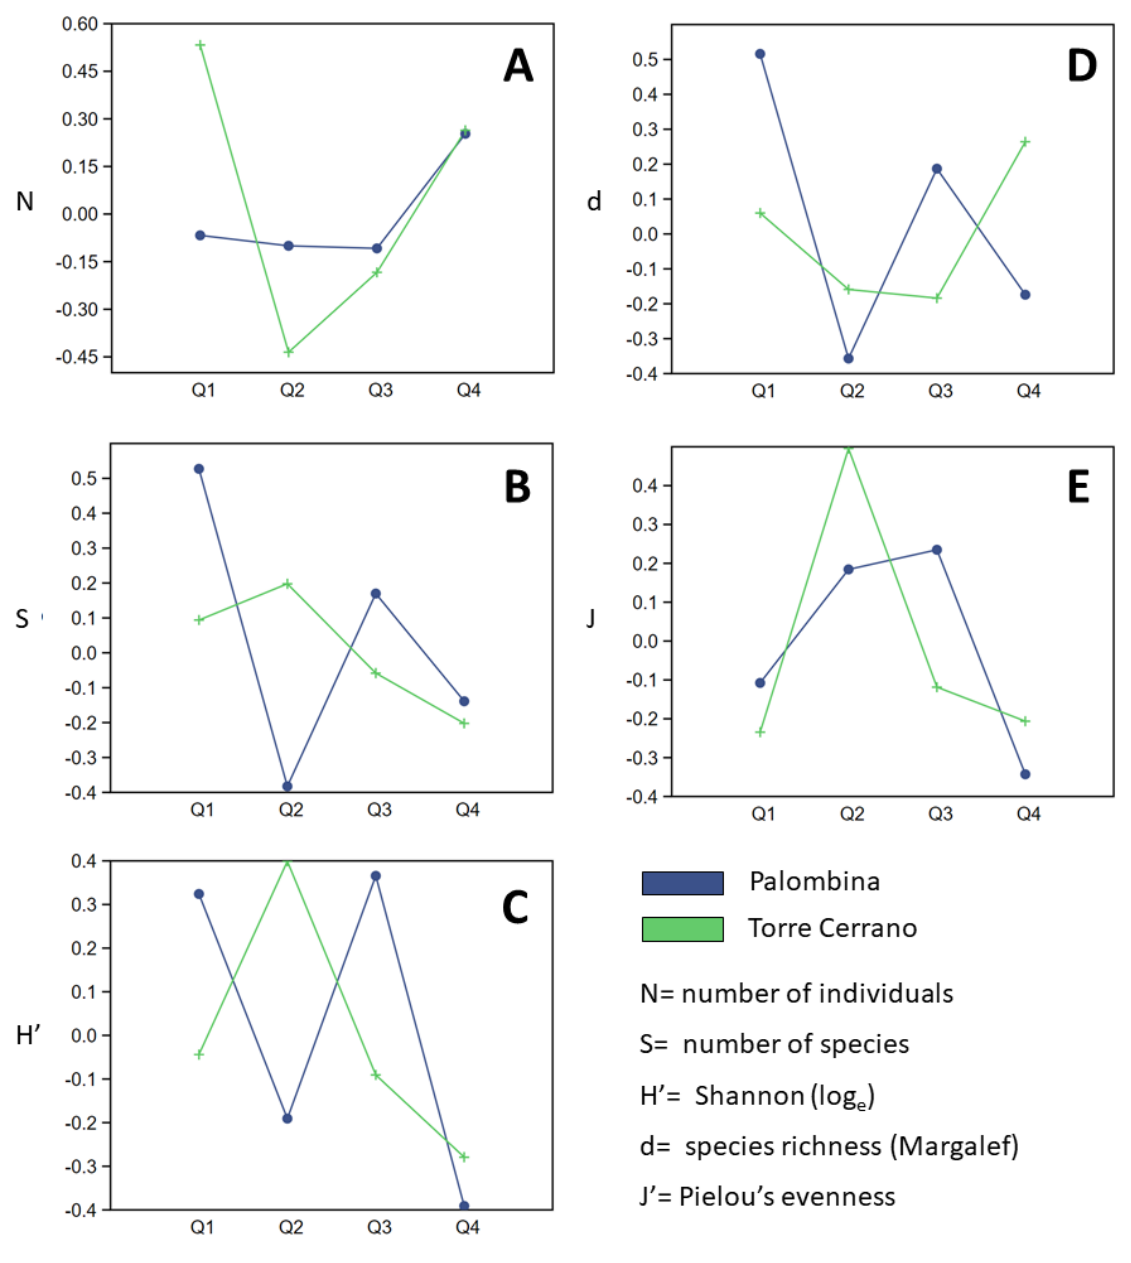
Figure 5. Diversity measured in Torre Cerrano and Palombina, PAST elaboration. In Torre Cerrano (green line), the number of individuals (N) ( A ), the number of species (S) ( B ) and species richness (d) ( D ) had the lowest values in Q2 (April, May, June), while diversity (H’ = 0.39) ( C ) and evenness (J’ = 0.49) ( E ) peaked in the same quarter. In Palombina (blue line), the number of individuals (N) ( A ) was constant in Q1, Q2 and Q3 and increased in the most uneven quarter, the Q4. The number of species ( B ) peaked in Q1, as well as species richness (d = 0.51) ( D ). Diversity (H ′ = 0 .36) ( C ) and evenness (J’ = 0.23) ( E ) were higher in Q3.